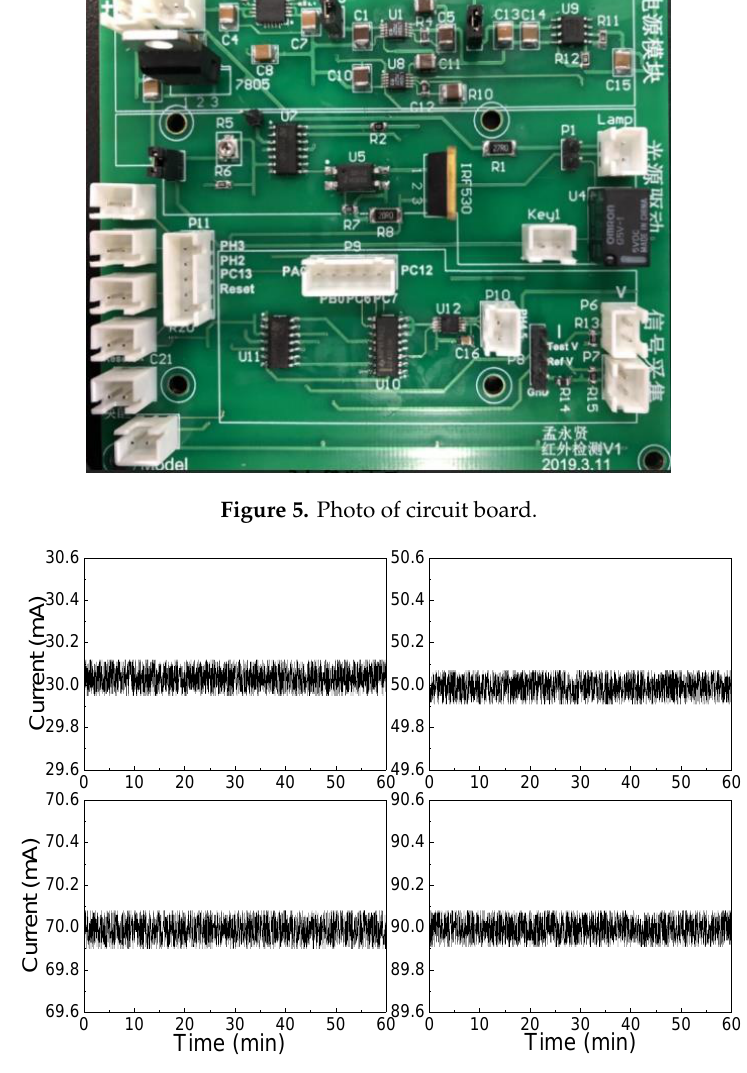
Figure 6. Flow chart of main detection procedure of STM32 processor.